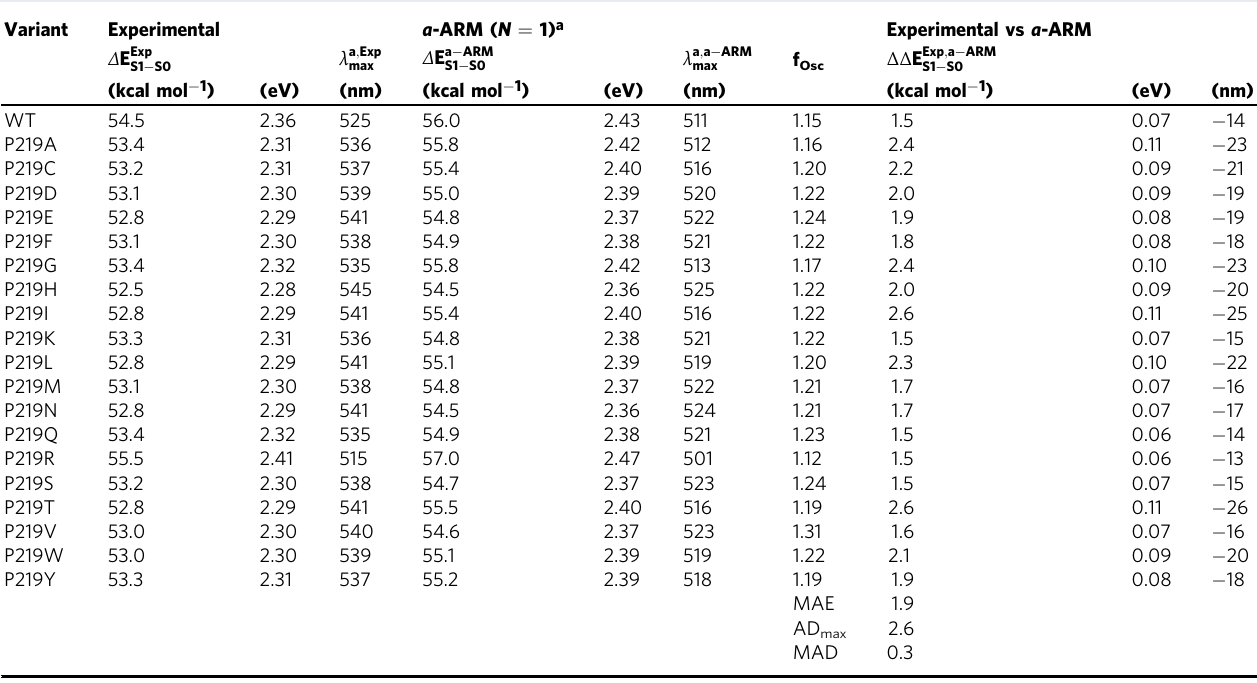
Table 1 a -ARM QM/MM models for the wild-type KR2 (WT-KR2) rhodopsin and 19 of its mutants (P219X, with X = A, C, D, E, F, G, H, I, K, L, M, N, Q, R, S, T, V, W, Y). First vertical excitation energy ( Δ E S1 − S0 ), maximum absorption wavelength ( λ a max ), transition oscillator strength (f Osc ), and difference between calculated and experimental data ð ΔΔ E Exp ; a (cid:1) ARM representative QM/MM